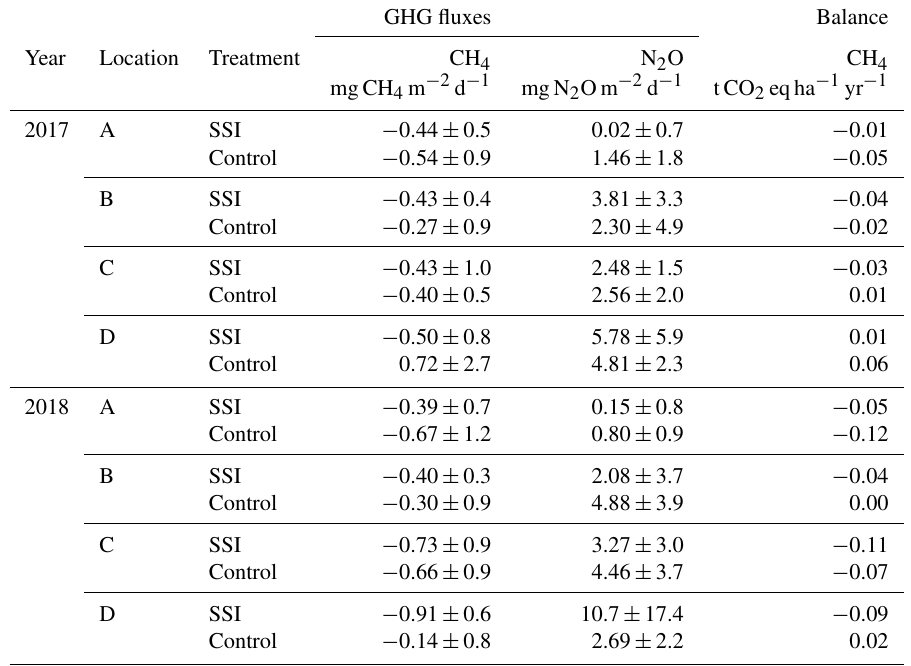
Table 4. The average measured CH 4 and N 2 O emissions subsoil irrigation (SSI) and controls for the four locations (A–D) for both years in mgm − 2 d − 1 . The total CH 4 balance in CO 2 equivalents, using radiative forcing factors of 34 for CH 4 according to IPCC standards (Myhre et al., 2013). The ranges of CH 4 and N 2 O represent the standard deviation (SD) of the measured